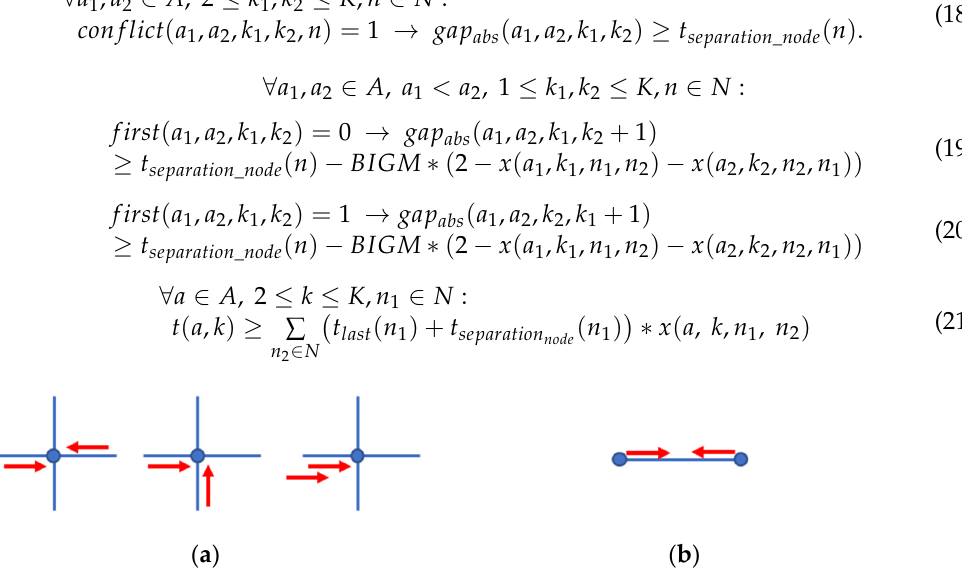
Figure 6. Two types of aircraft conflict on a taxiway. ( a ) 1st type conflict at each node. ( b ) 2nd type conflict at each edge.